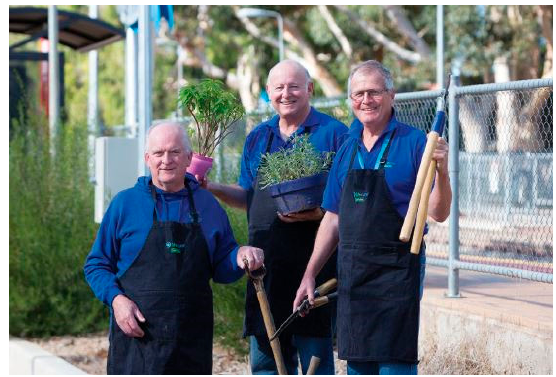
Figure 8. Unley gardening volunteers [23].